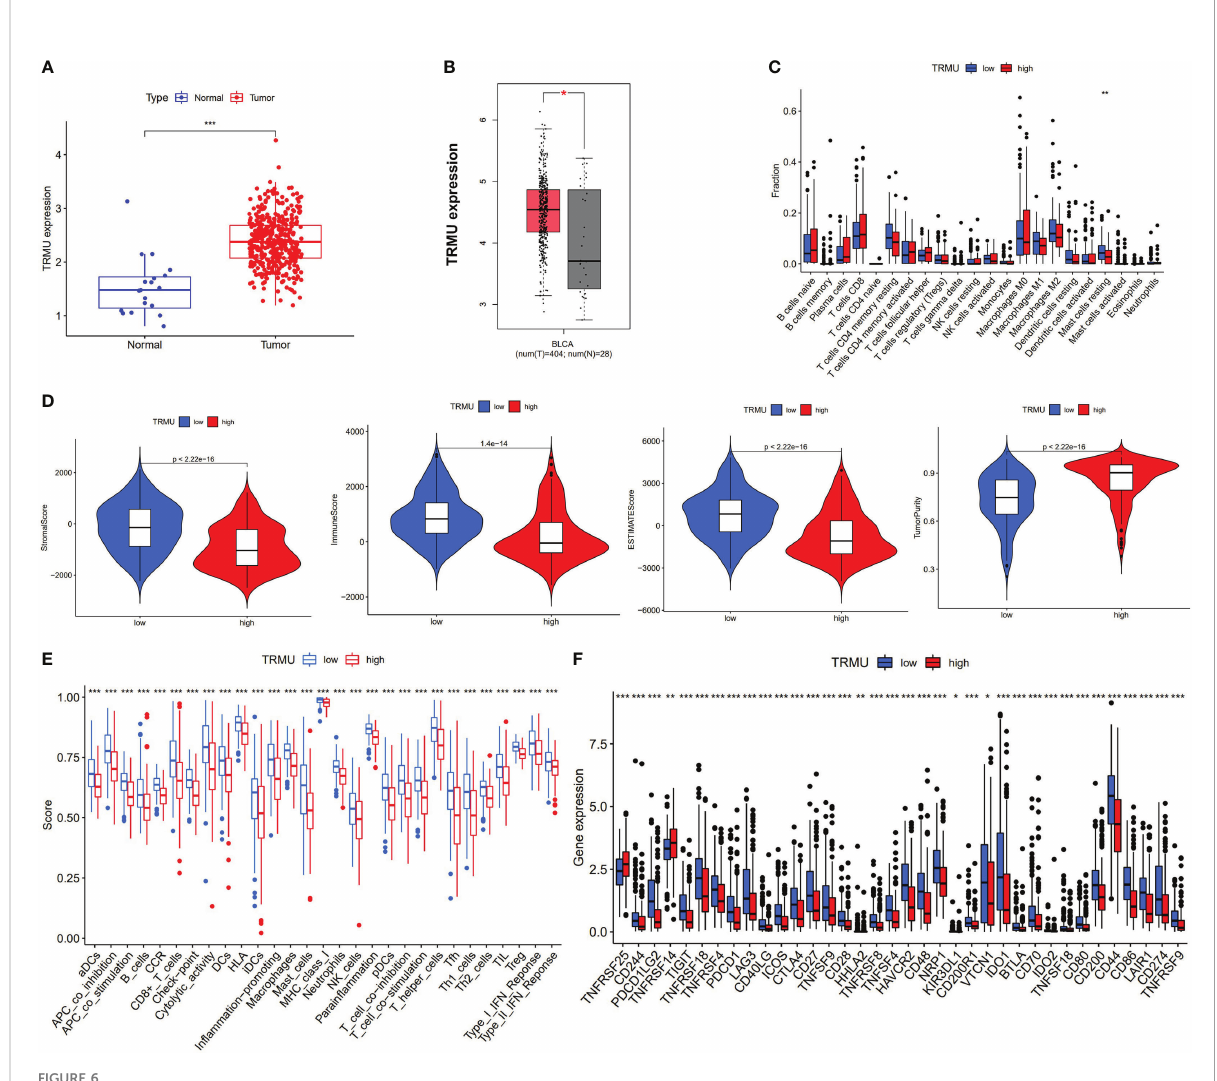
FIGURE 6 Correlation between TRMU and immunological features. (A) The expression of TRMU between normal tissues and tumor tissues. (B) The expression of TRMU veri fi ed by GEPIA2 database. (C) Comparison of immune cells between low-TRMU group and high-TRMU group. (D) Comparison of stromal score, immune score, estimate score, and tumor purity between low-TRMU group and high-TRMU group. (E, F) Comparison of immune-related pathway and immune checkpoint genes among two subgroups. * p < 0.05, **p < 0.01, ***p <